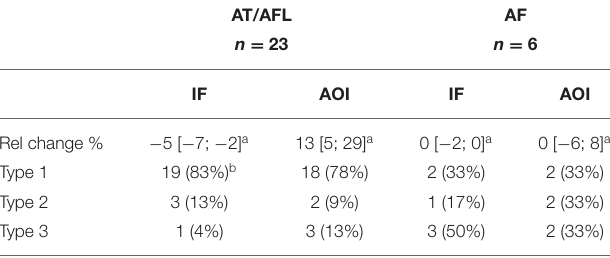
TABLE 4 | Relative changes in IF and AOI post-PVI, according to form of recurrence, expressed as median with [25th; 75th] percentiles. AT/AFL